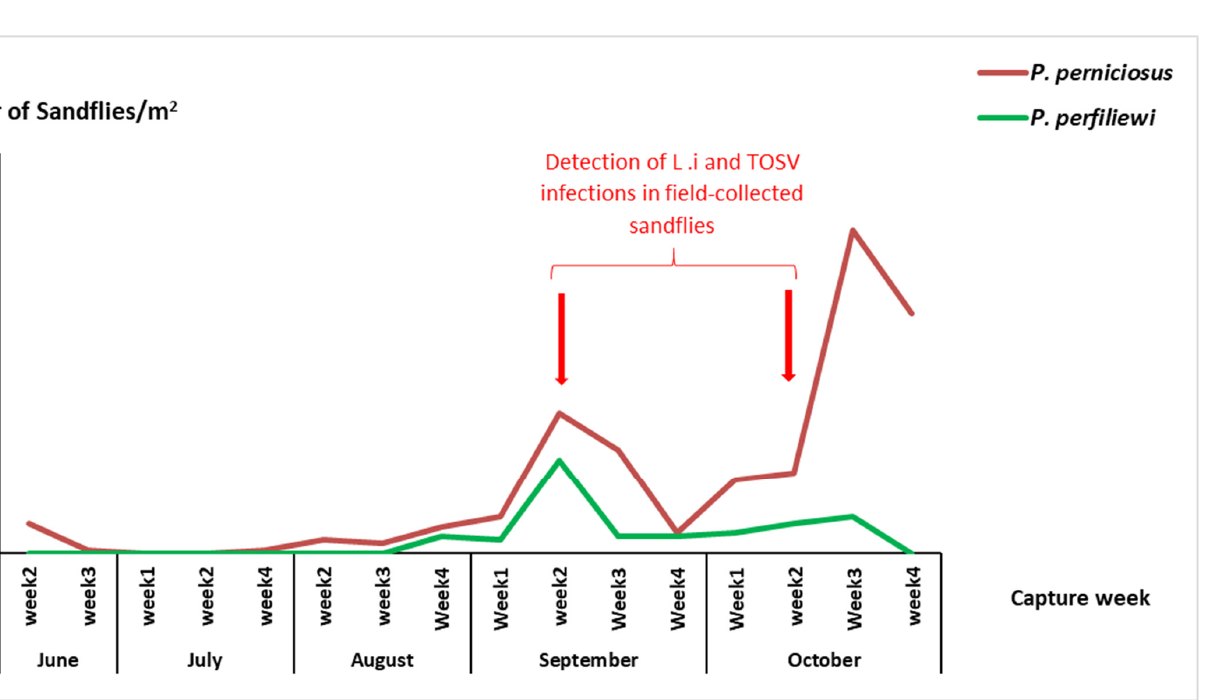
Figure 1. Phenology of sand fl ies of the subgenus Larroussius , collected in the exposure site, 2020 (L. i: L. infantum , TOSV: Toscana